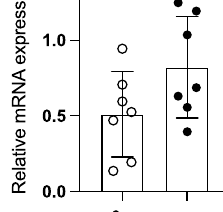
Figure 2. Overexpression of HCV-core protein in mice liver causes hepatic and muscle insulin resistance and increases ANGPTL4 expression. ( a ) Glucose tolerance test in mice infected with either AAV8-GFP or AAV8-3a for 3 months performed after overnight fasting; ( b ) Insulin tolerance test performed after 4 h of food deprivation; and ( c-d ) Representative immunoblots of pAkt Ser473, pAkt Thr308 and Akt total expression in the liver ( c ) and the gastrocnemius muscle ( d ) of AAV8-GFP and AAV8-3a mice challenged with insulin. ( e ) Angptl4 mRNA expression in liver of mice expressing either the HCV-3a core or GFP in the hepatocytes. Quantification were performed on 4–5 mice/group. * p < 0.05, ** p < 0.01 and **** p <